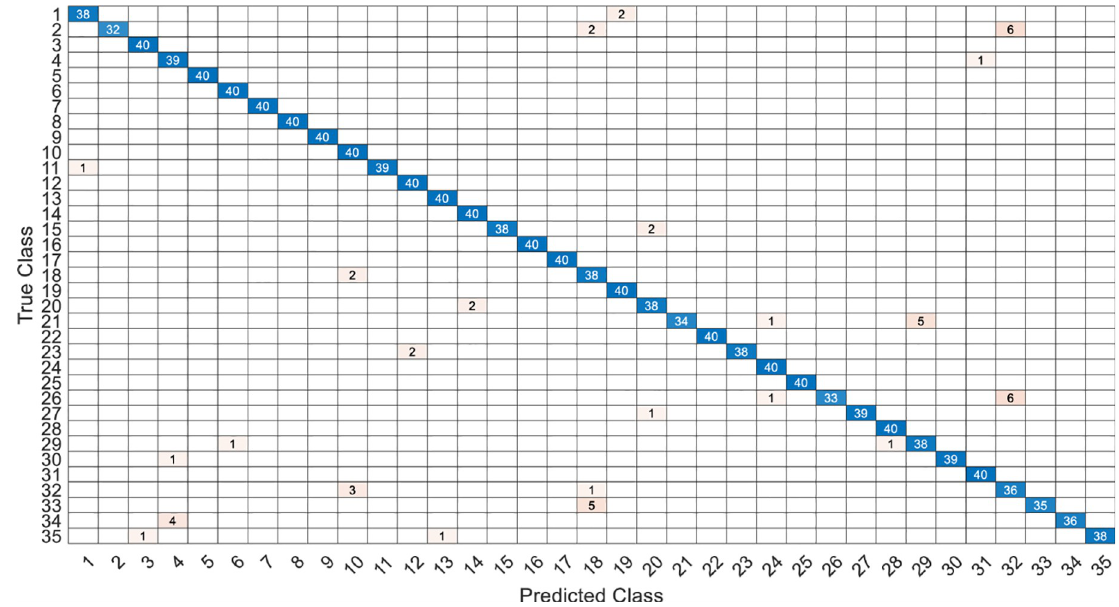
Fig 36. The confusion matrix of PCA-LSTM-2 × 200 model with LPC datasets.